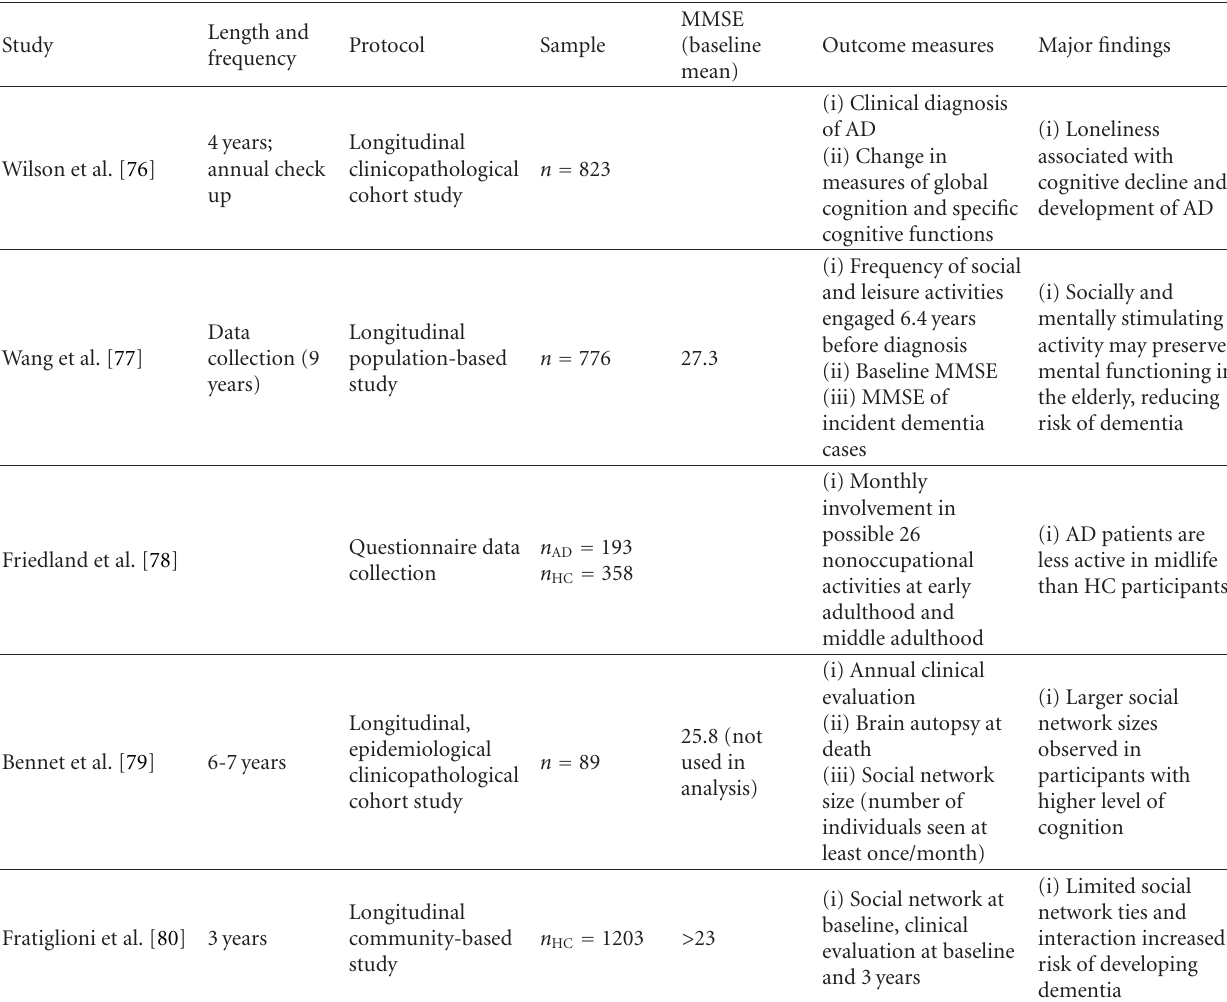
Table 3: Summary of studies on the e ff ect of socialization on incident